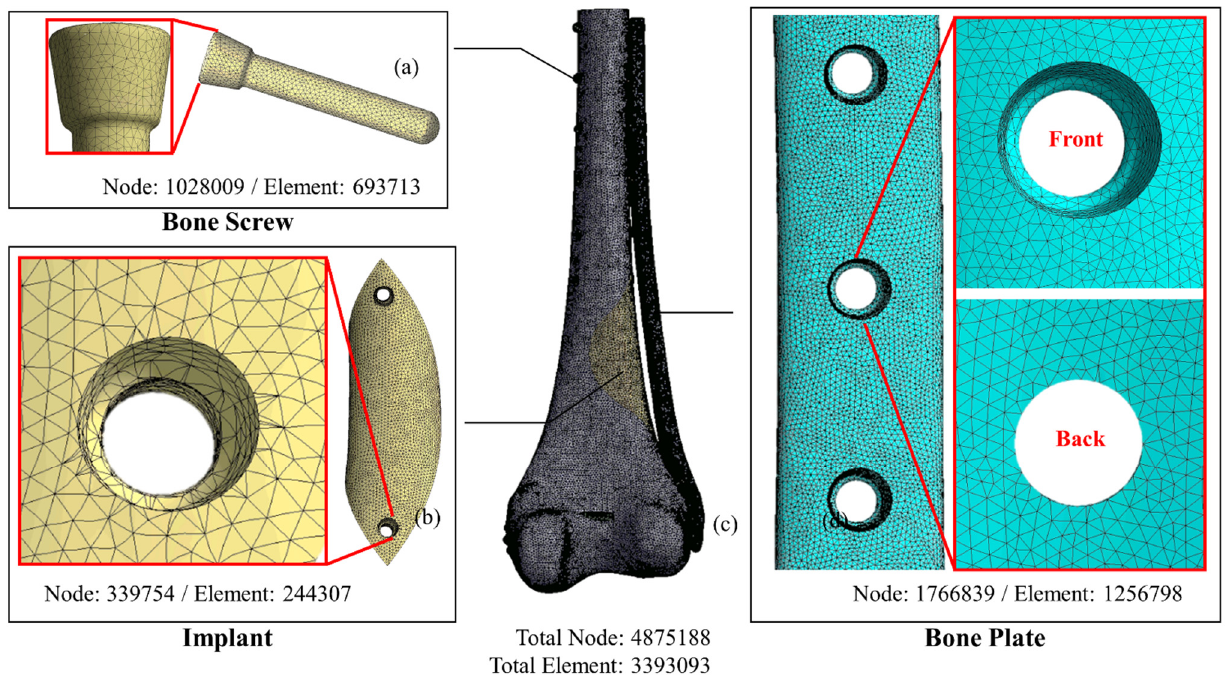
Figure 3. FE models of the system components. ( a ) bone screw; ( b ) solid implant; ( c ) femur; ( d ) bone plate.